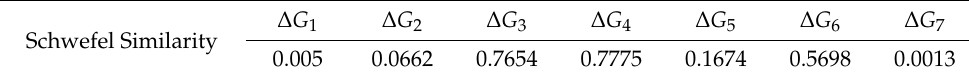
Table 2. Schwefel function and ∆ G similarity.